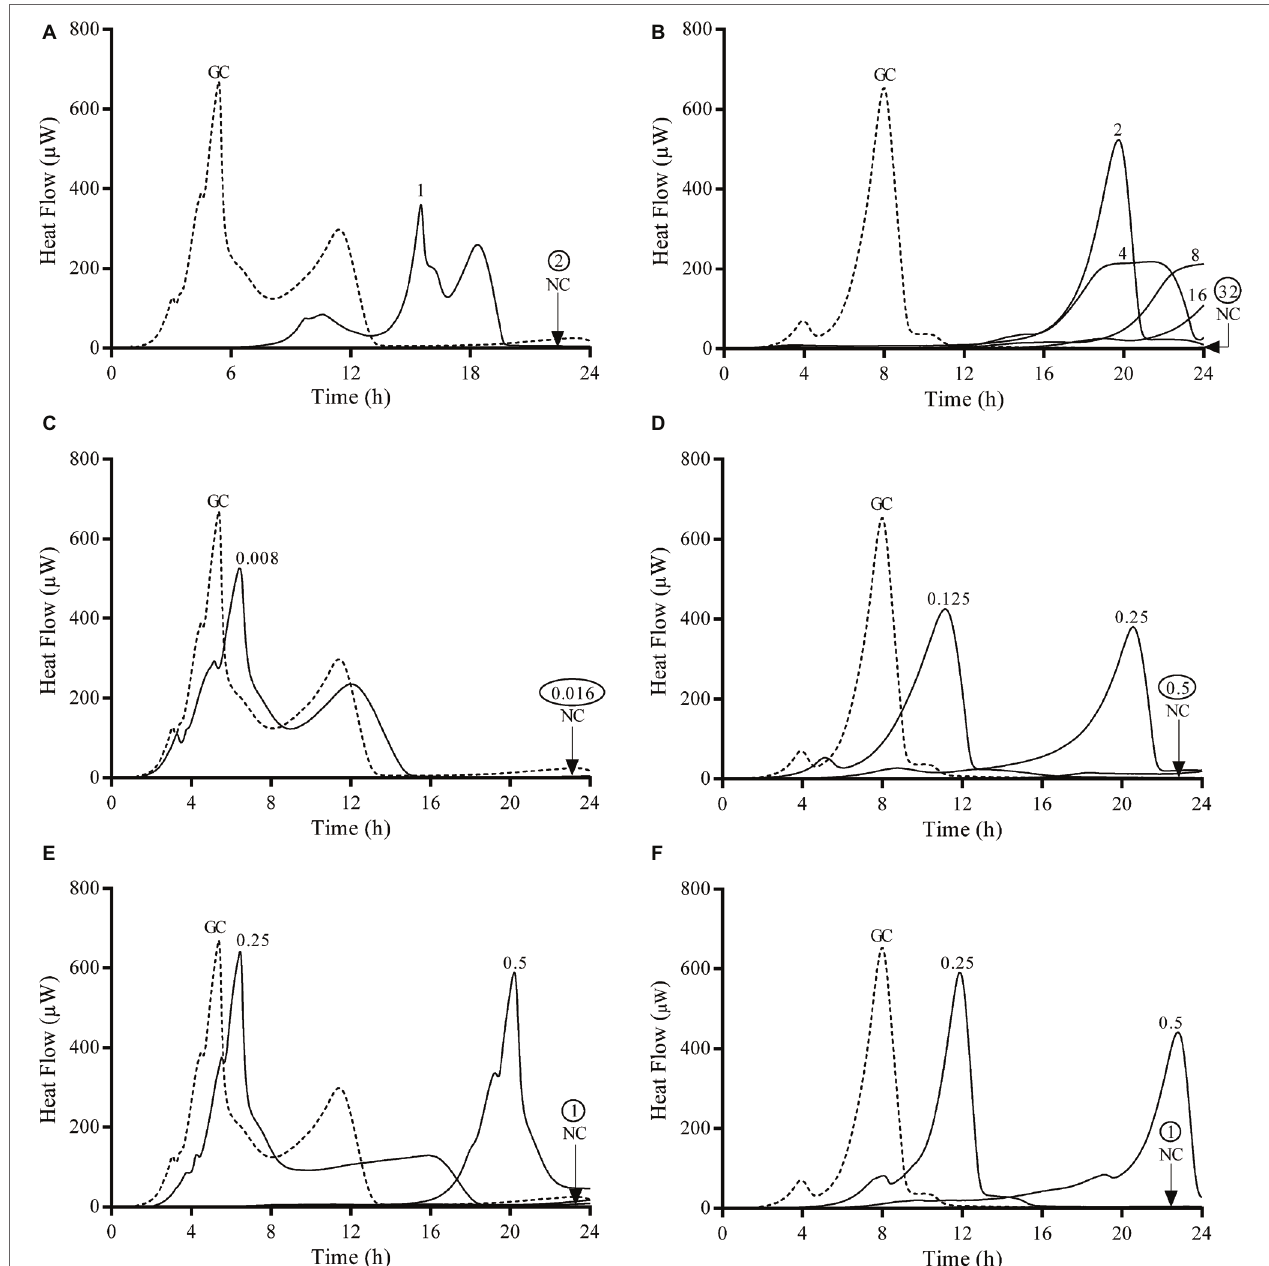
FIGURE 1 | Microcalorimetry analysis of planktonic bacteria exposed to serial antibiotic concentrations for 24 h. Numbers represent concentrations (in μg/ml) of fosfomycin (A,B) , ciprofloxacin (C,D) , and gentamicin (E,F) against E. coli ATCC 25922 (left column) and P. aeruginosa ATCC 27853 (right column). Circled values represent the MHIC. GC, growth control; NC, negative control. Data of a representative experiment are